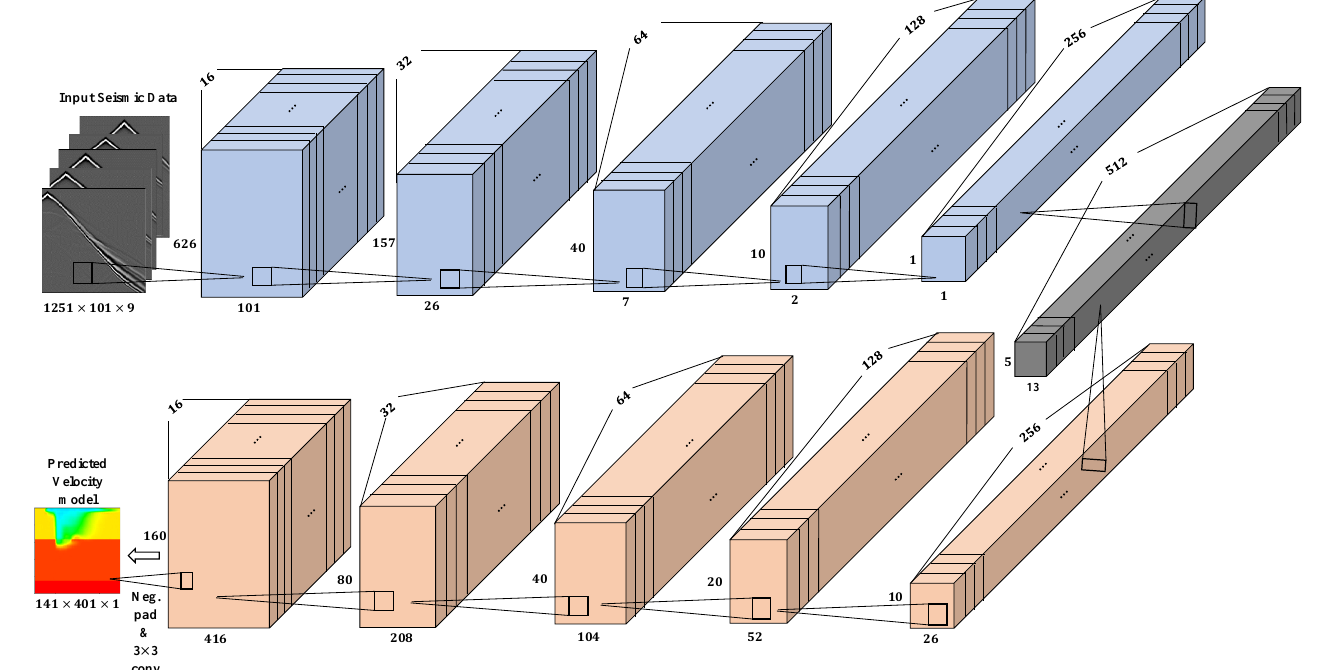
Figure 5. Modified InversionNet architecture used for the seismic